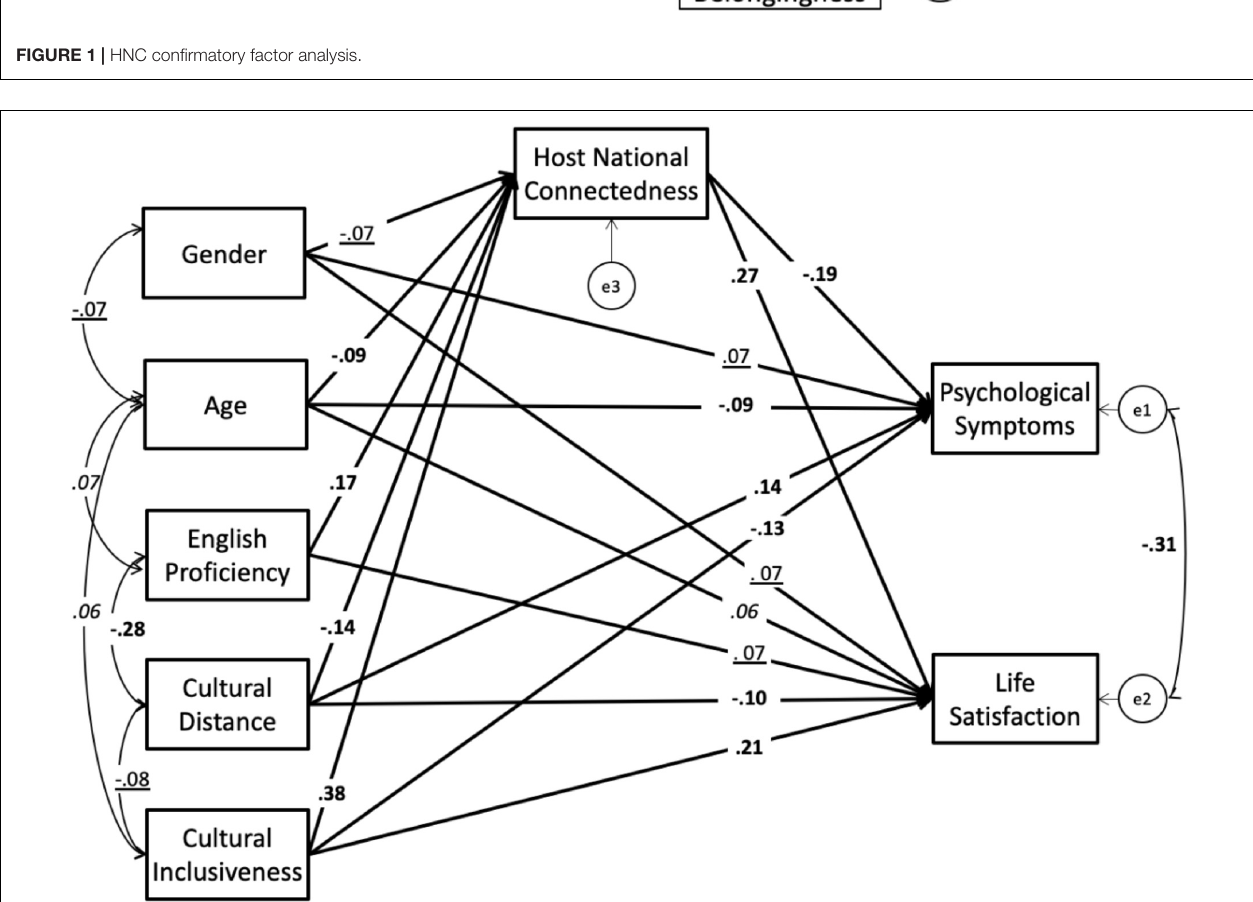
FIGURE 2 | Mediational model of psychological adaptation. Standardized coefficients are displayed. Coefficients significant at 0.05 are italicized, and those significant at 0.01 are underlined; all other coefficients are significant at